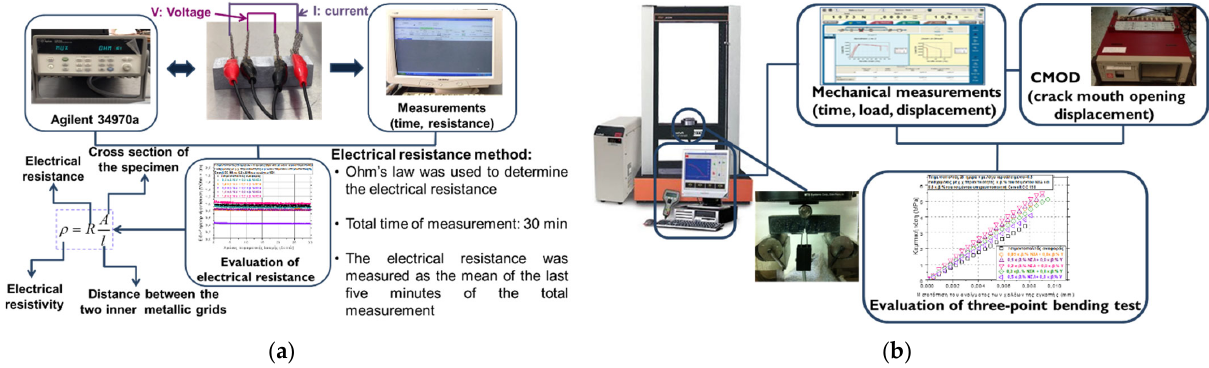
Figure 3. Experimental details of the ( a ) electrical resistance measurements and ( b ) flexural testing.